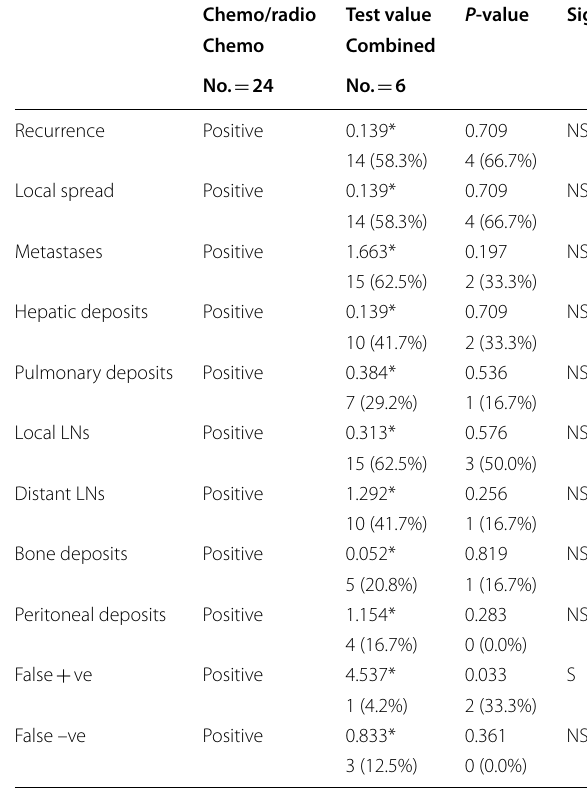
Table 4 Relation of pathological results of the studied patients with PET-CT findings in follow up patients with colorectal carcinoma after adjuvant chemotherapy